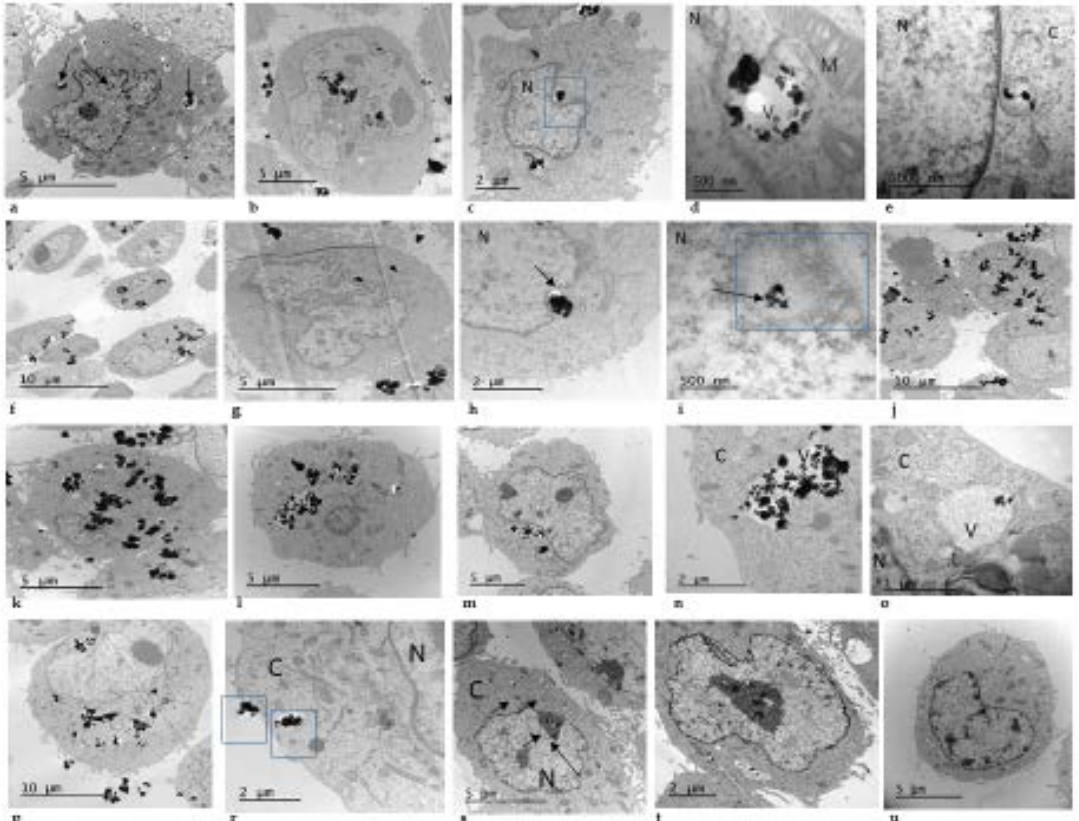
Figure 2. Representative transmission electron microscopy (TEM) figures of titanium dioxide TiO 2 NM105 uptake by Chinese hamster lung fibroblast (V79-4) cells exposed to 3, 10 and 30 µ g / cm 2 of TiO 2 NPs dispersed according to dispersion procedure 1 (DP1) and dispersion procedure 2 (DP2). DP1 3 µ g / cm 2 ( a – e ), DP1 10 µ g / cm 2 ( f – i ), DP1 30 µ g / cm 2 ( j , k ), DP2 3 µ g / cm 2 ( l – o ), DP2 10 µ g / cm 2 ( p – r ), DP2 30 µ g / cm 2 ( s , t ), Negative control untreated V79-4 cells ( u ). N = nucleus; C = cytoplasm; V = vesicle, M = mitochondrion.